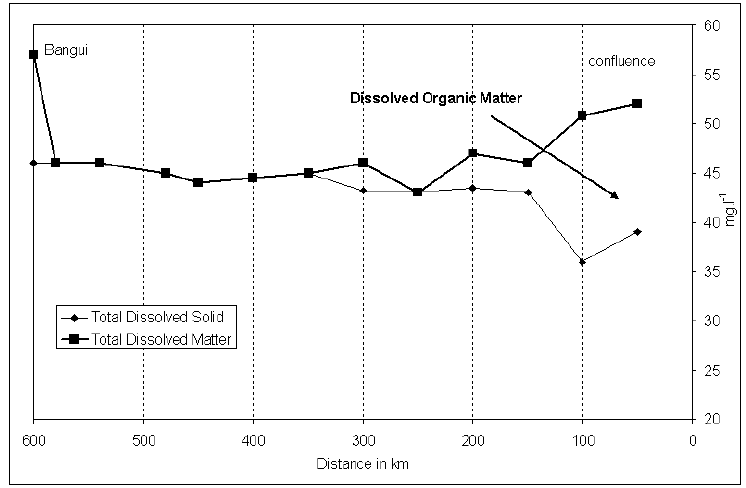
Figure 16. Evolution of dissolved matters during the Ubangi cruise in November 1992 [15].